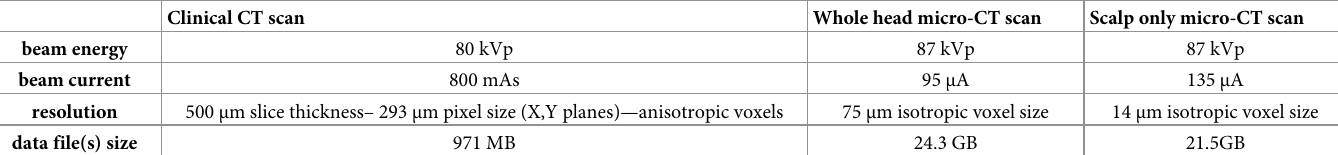
Table 1. Comparable image settings for the three